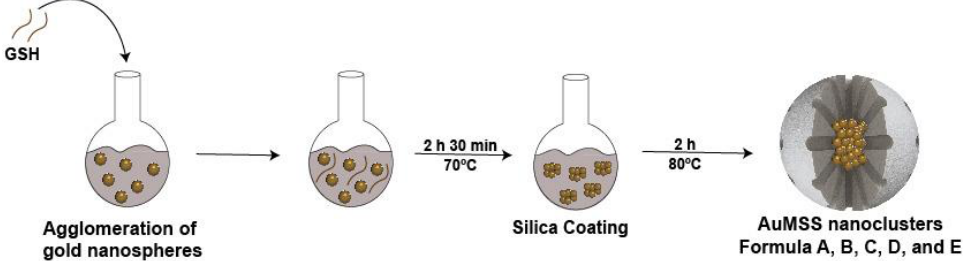
Figure 1. Representation of the nanoclusters’ optimization synthesis.